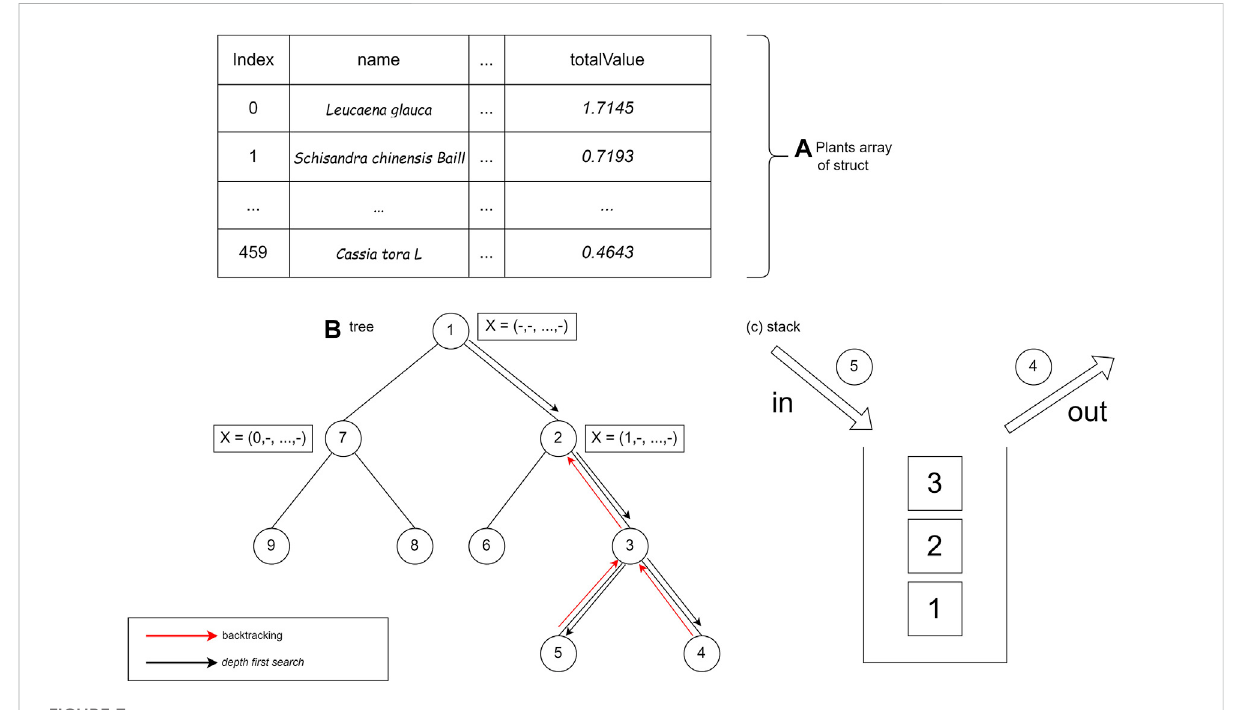
FIGURE 7 Use of the stack data structure on the tree.